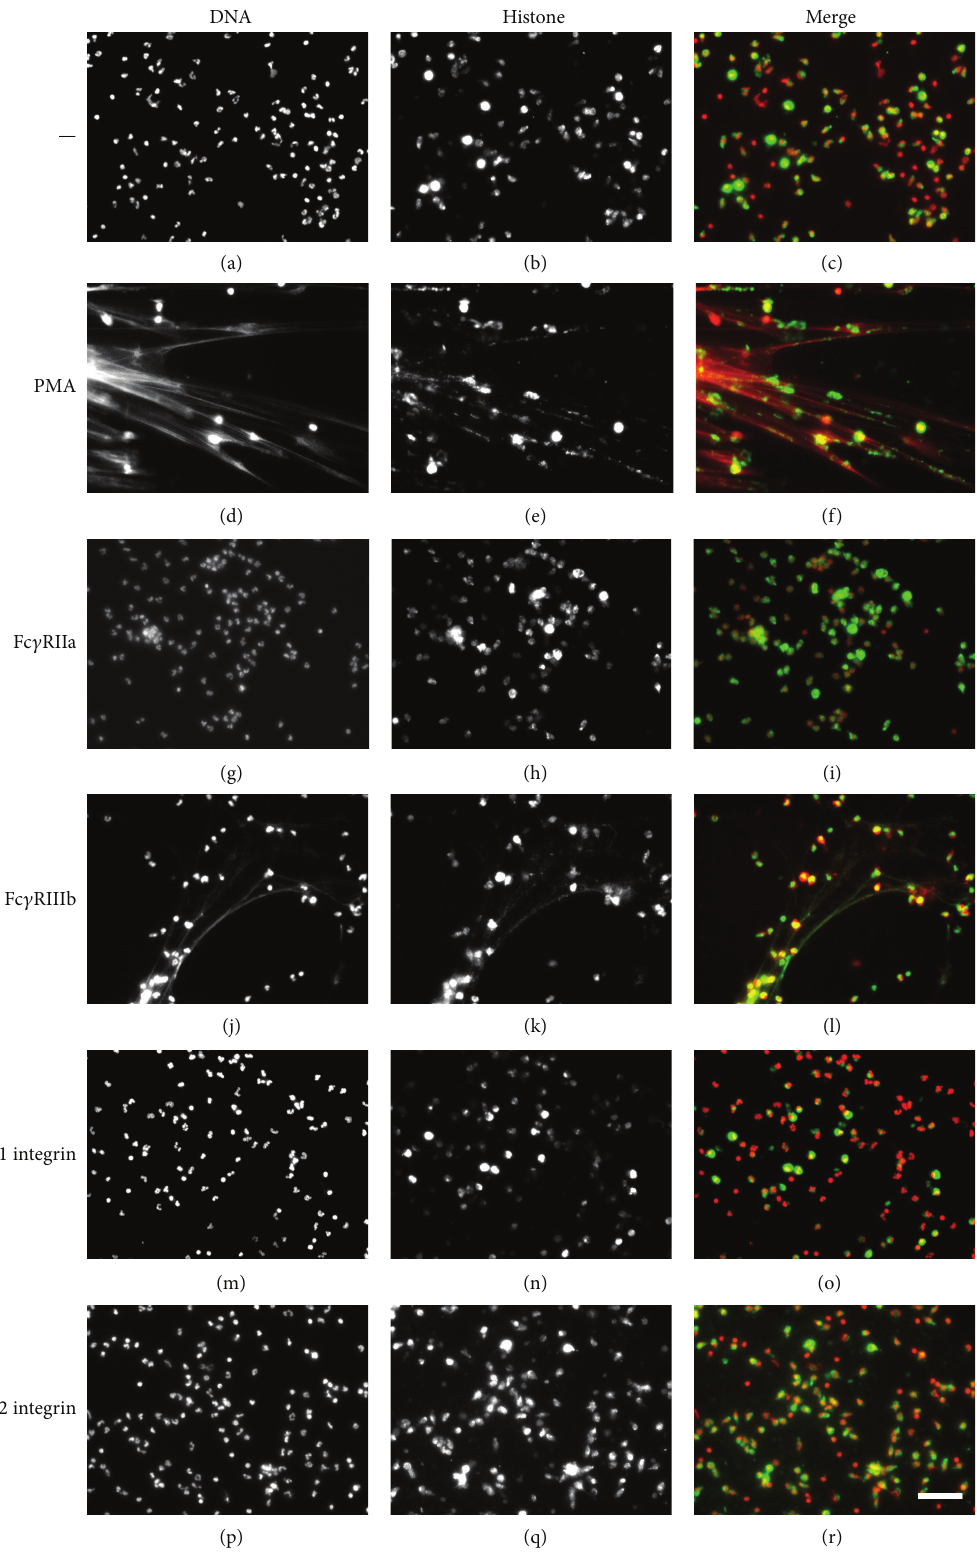
Figure1:Fc 𝛾 RIIIbinducesNETformation.(a)Humanneutrophils(PMN)wereleftuntreated(—)orwerestimulatedwith20 nMphorbol12- myristate 13-acetate (PMA), by cross-linking Fc 𝛾 RIIa with mAb IV.3, by cross-linking Fc 𝛾 RIIIb with mAb 3G8, by cross-linking 𝛽 1 integrins with mAb TS2/16, or by cross-linking 𝛽 1 integrins with mAb IB4. After four hours, PMN were fixed and stained for DNA (DAPI, red) and for histone (green). Microphotographs were taken at 200x magnification and are representative of more than 10 experiments. Bar is 50 𝜇